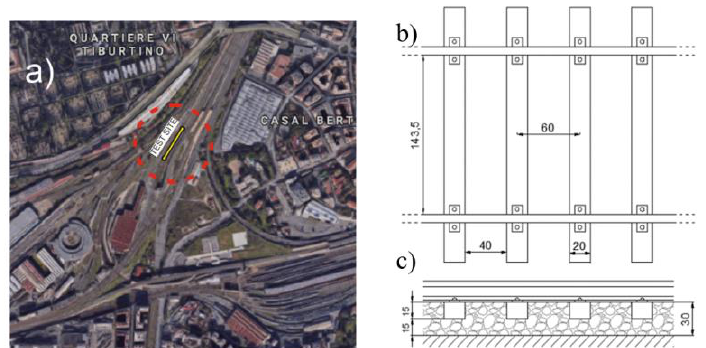
Figure 2. ( a ) Location of the test-site; ( b ) plan view of the inspected railway section; ( c ) cross-section of the track-bed. The measures are expressed in cm.